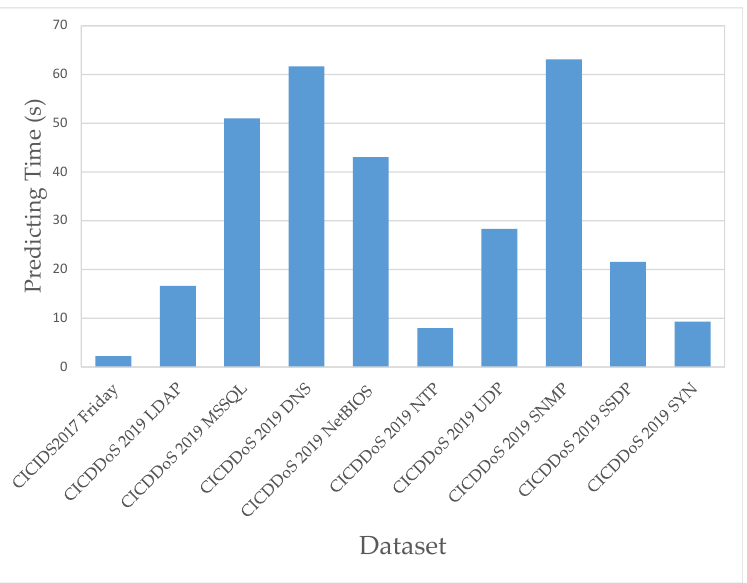
Figure 9. The 1D-DHRNet-OCSVM model ‘ s prediction time on 10 unknown datasets .